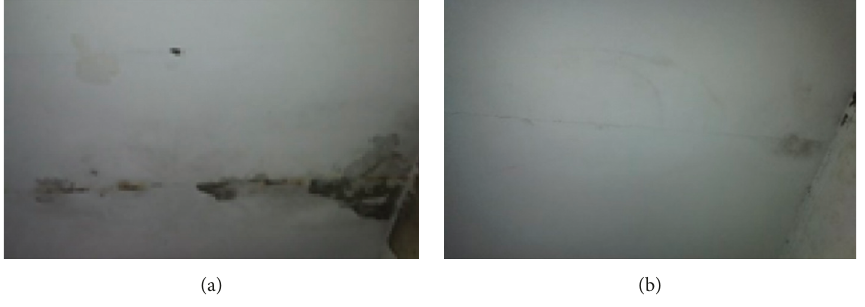
Figure 6: Cracks of precast floor slab joint.